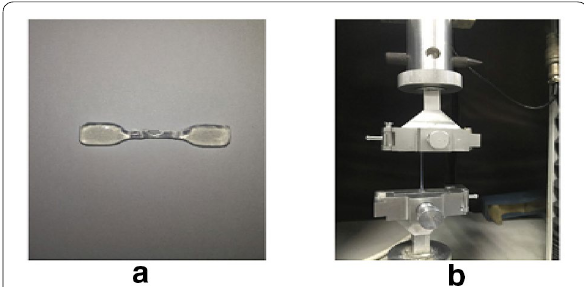
Figure 6 Distribution of markers buried in the phantom using markers’